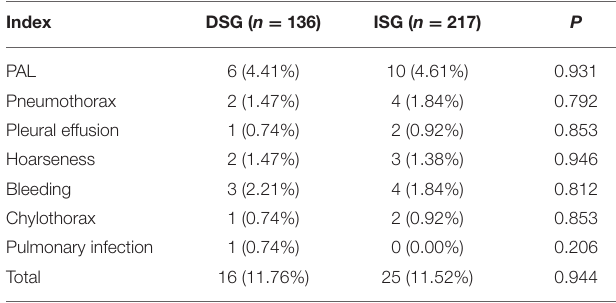
TABLE 2 | The comparision of postoperative complications between the two groups.